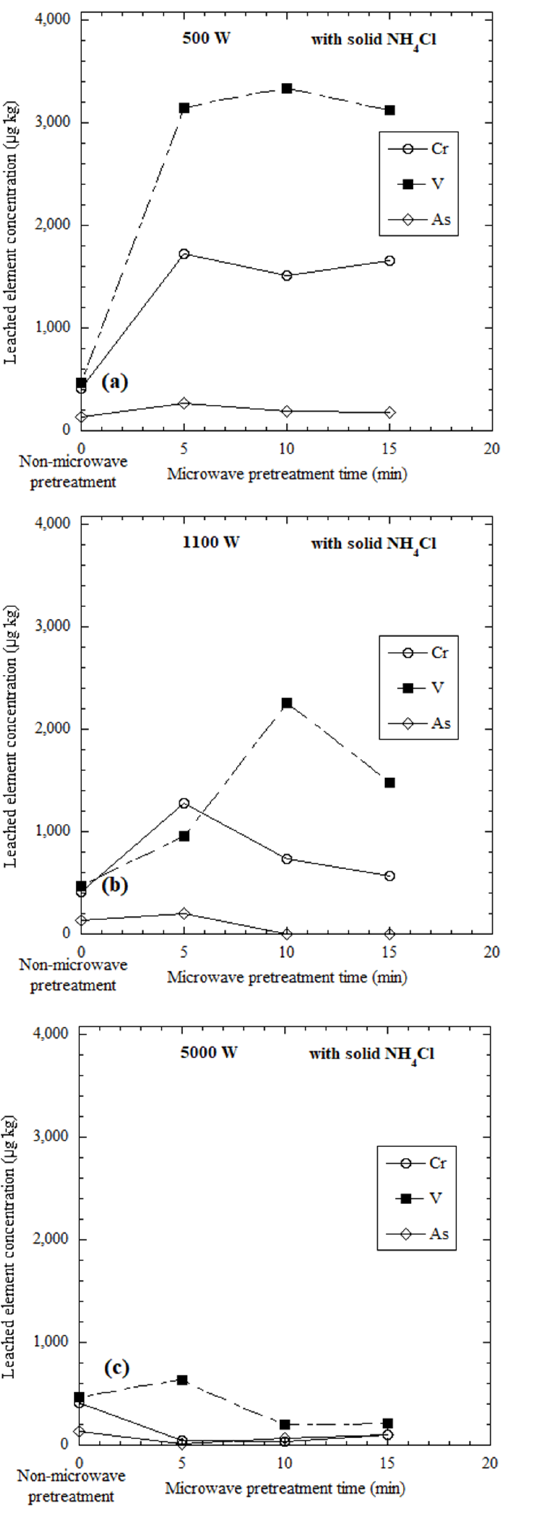
Figure 4. Cr, V, and As leached concentrations at various output powers: ( a ) 500 W, ( b ) 1100 W, and ( c ) 5000 W and Co, Cu, Mn, Ni, Pb, and Zn leached concentrations at various output powers: ( d ) 500 W, ( e ) 1100 W, and ( f ) 5000 W from the red mud-solid NH 4 Cl microwave-pretreated at various output powers. Table 3. Optimal conditions for the maximum element recovery from the red mud.